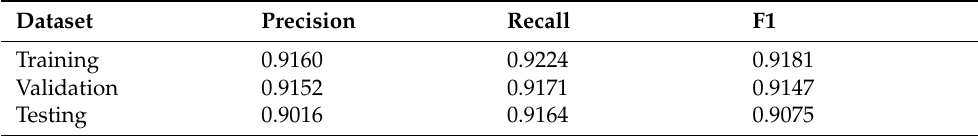
Table 2. Performance of U-net model for concrete crack segmentation.